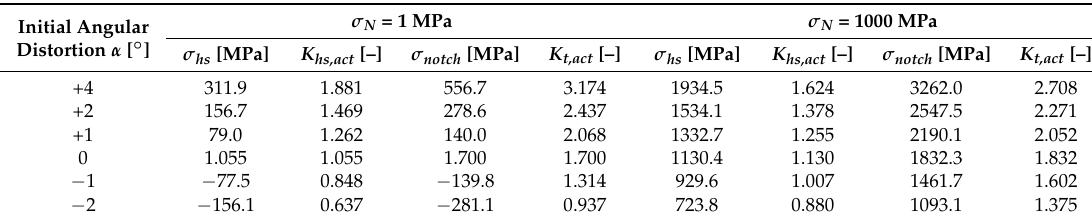
Table 5. Stresses resulting from 1 and 1000 MPa nominal loading